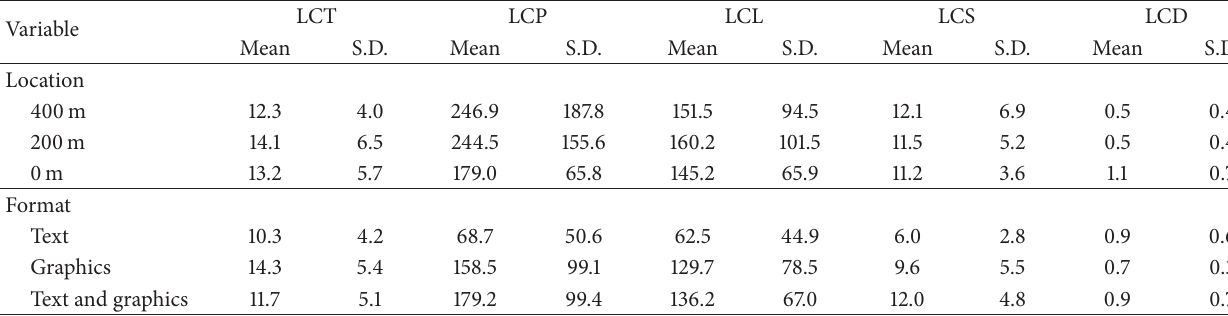
Table 4: Descriptive statistical results for LCT, LCP, LCL, LCS, and